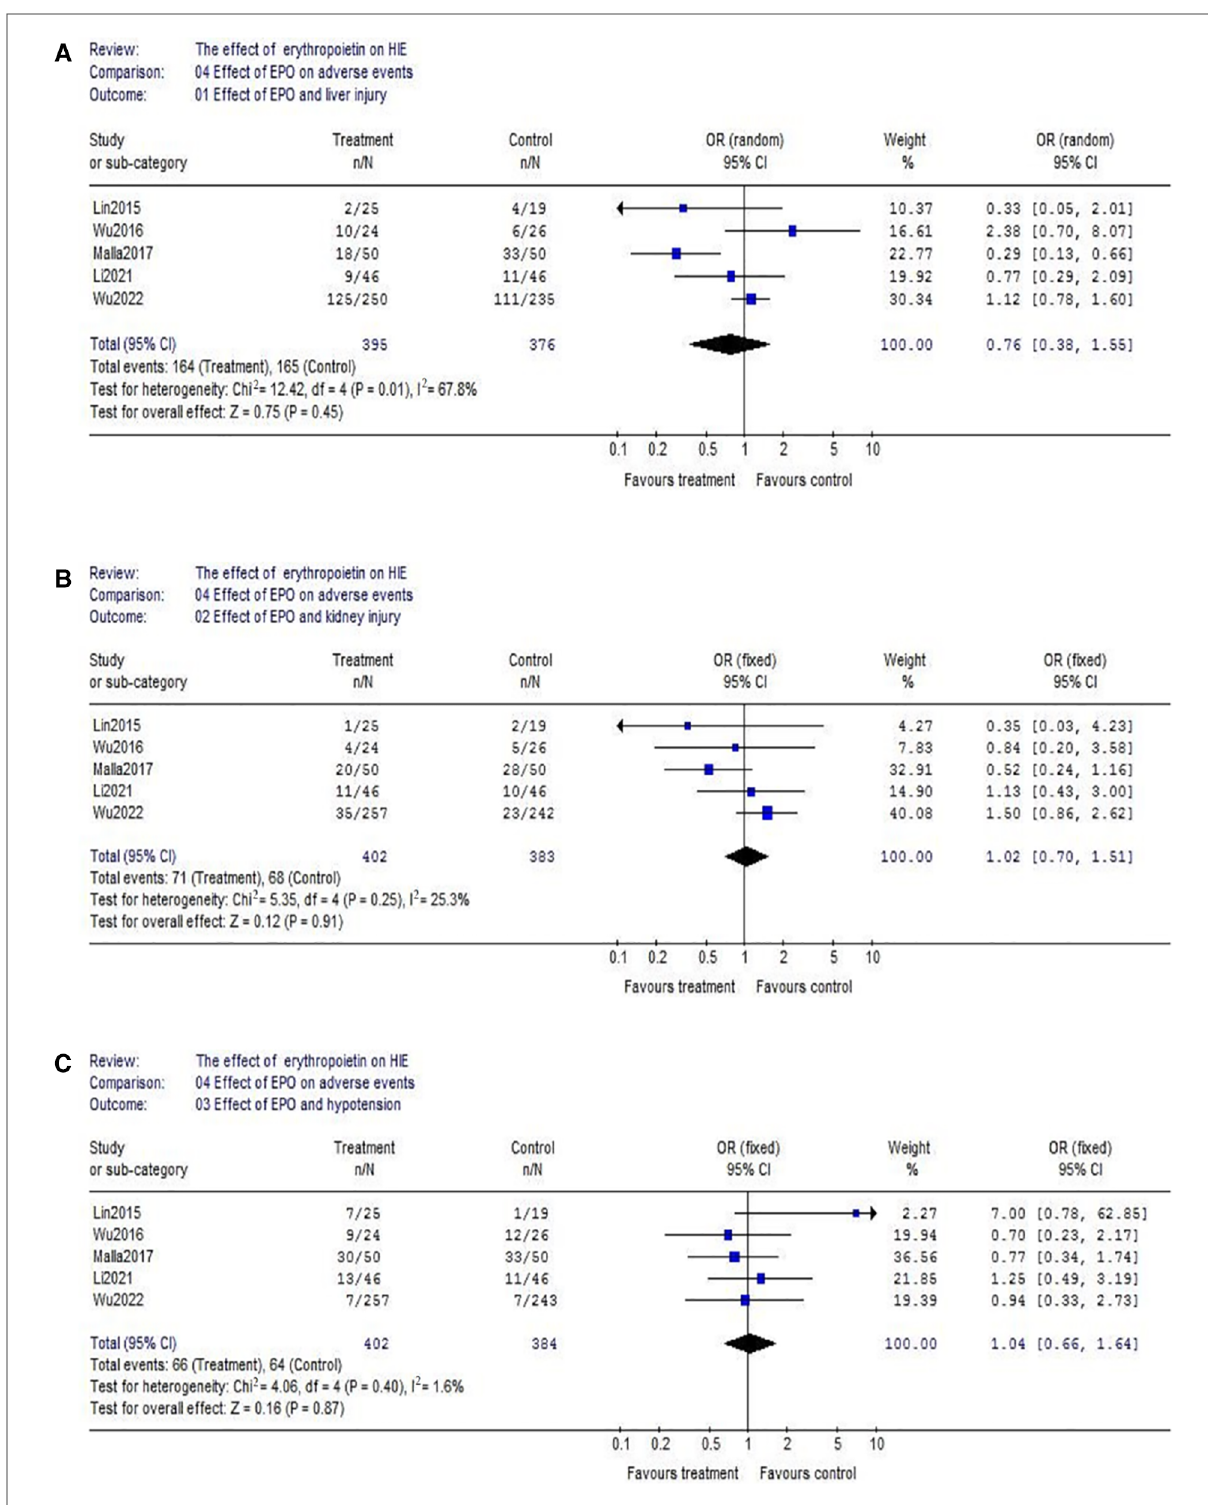
FIGURE 7 Effect of EPO on hepatic injury, kidney injury and hypotension. ( A ) Effect of EPO and liver injury; ( B ) Effect of EPO and kidney injury; ( C ) Effect of EPO and